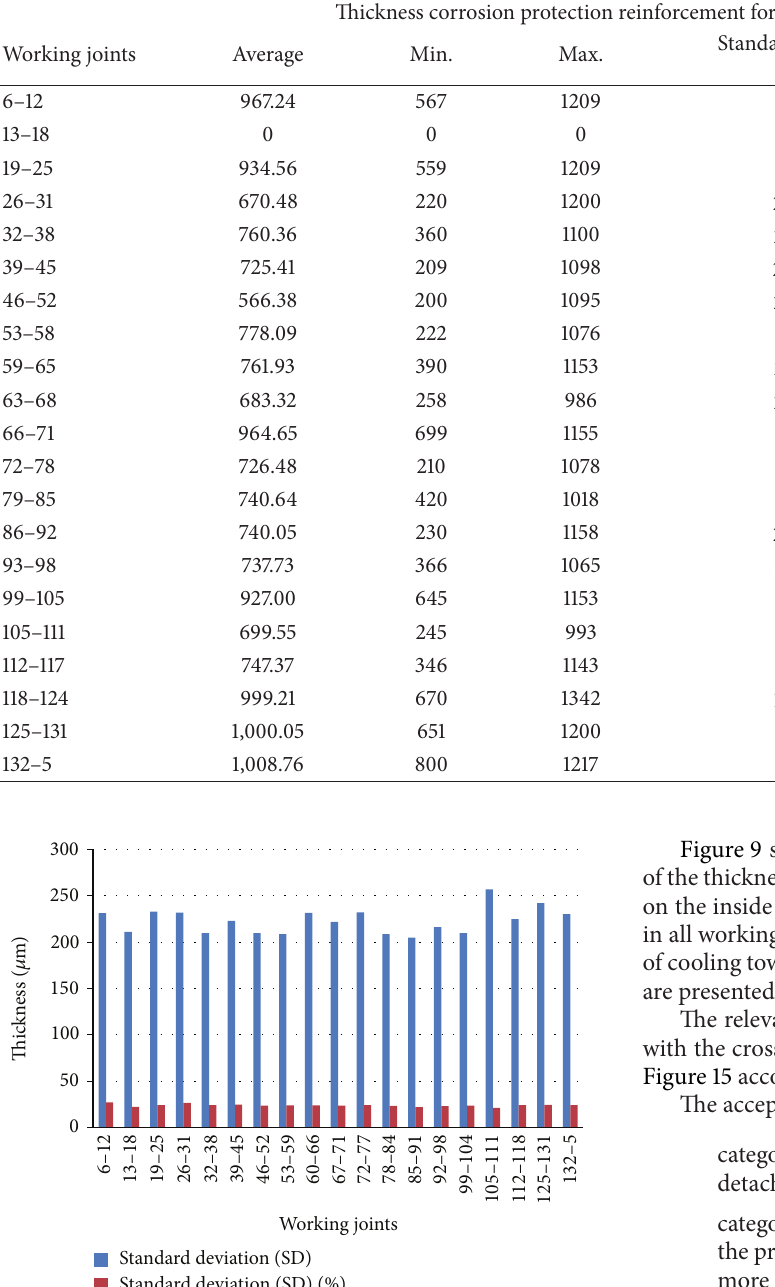
Table 2: Thickness protection coating in 𝜇 m of reinforcement for external shell. Thickness corrosion protection reinforcement for external shell.